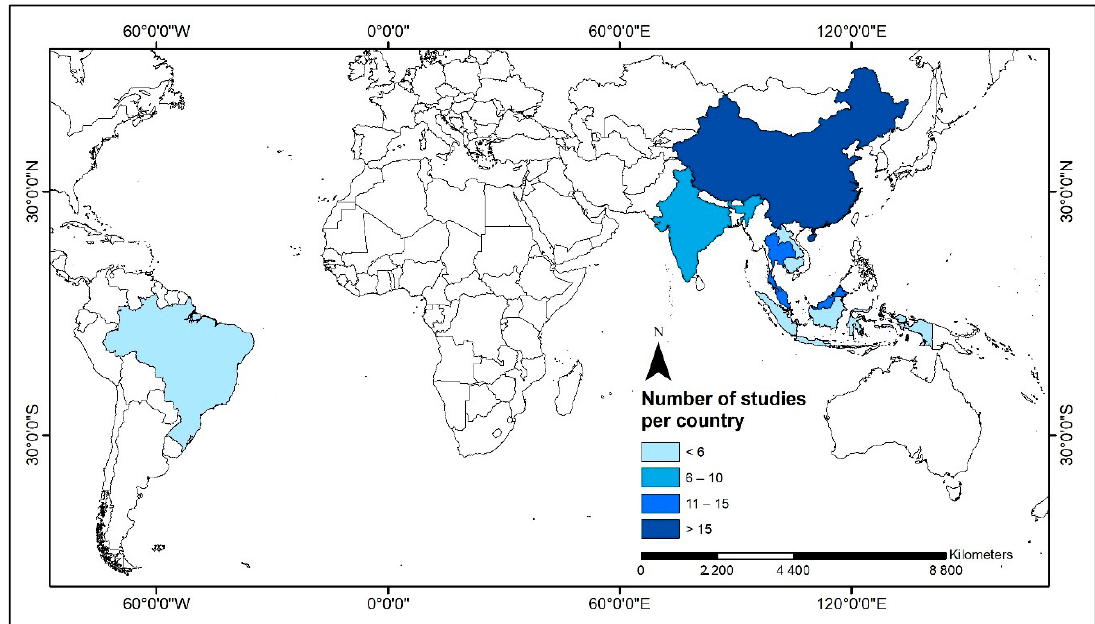
Figure 3. Map of the number of studies per country for local study setting.